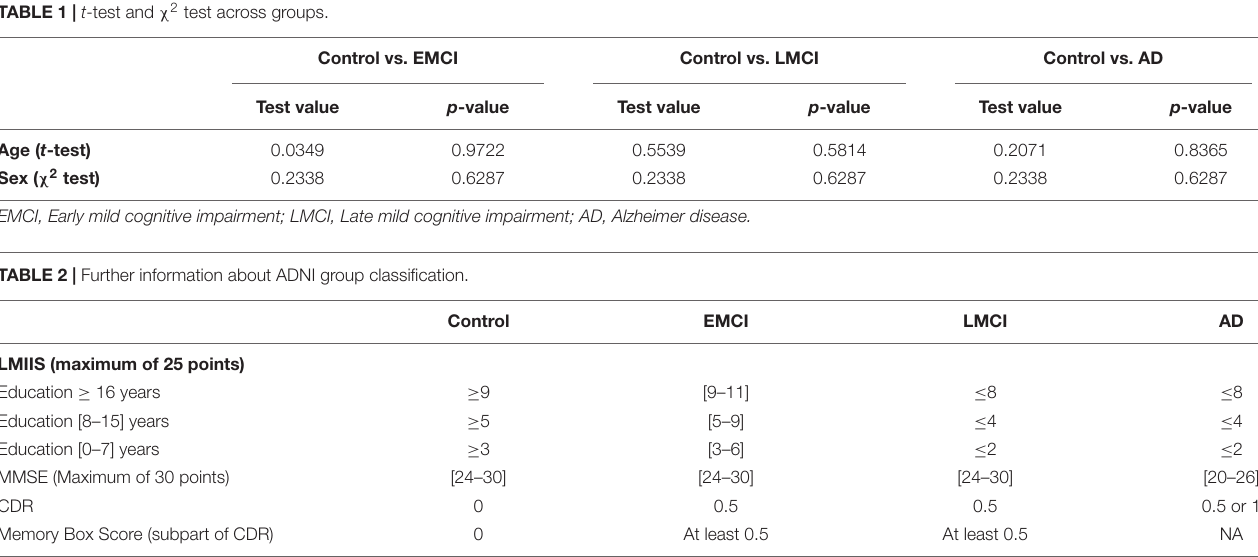
TABLE 1 | t -test and χ 2 test across groups.